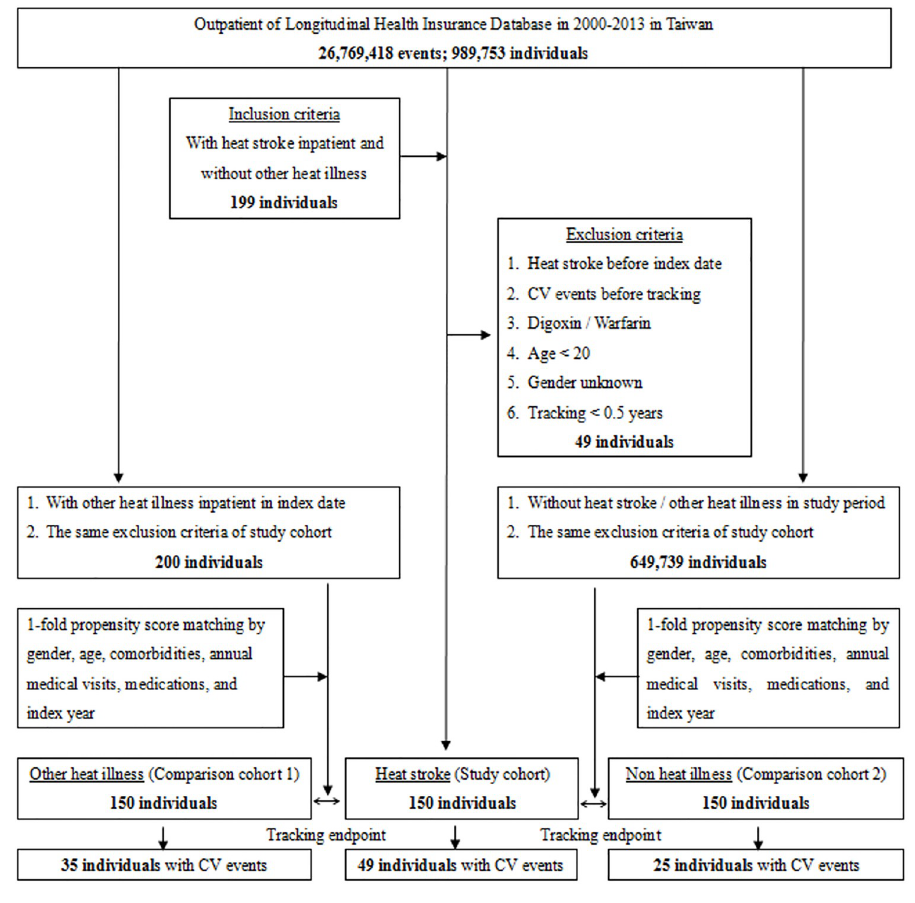
Fig 1. Patient selection flowchart. CV events = cardiovascular